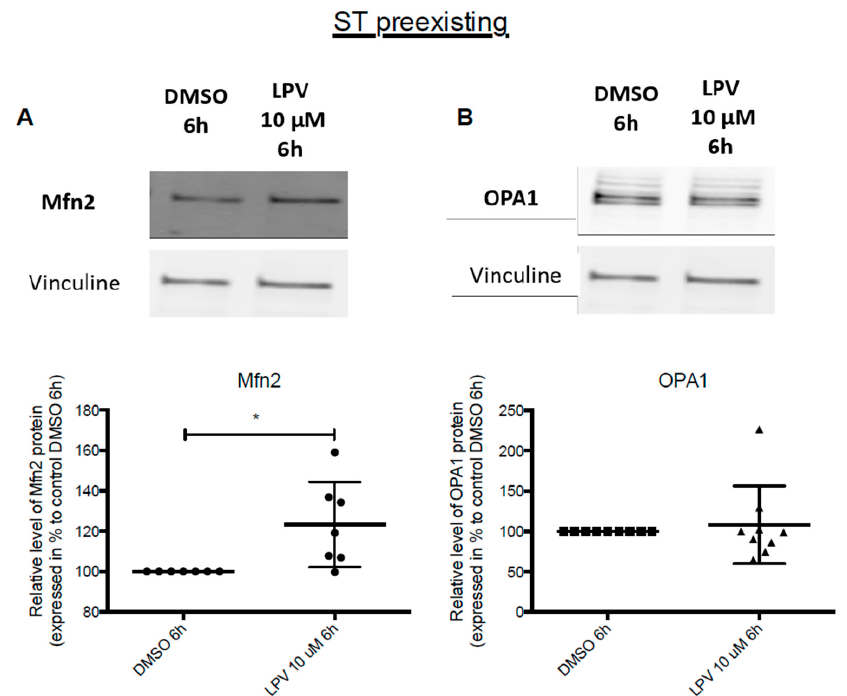
Figure 11. Impairment in mitochondrial dynamics in ST cells under LPV exposition. Cytotrophoblast cells isolated from human term placentas were cultured for 72 h before incubation with LPV 10 µ M or DMSO for 6 h. Mfn2 ( A ) and OPA1 ( B ) protein expression was evaluated by immunoblotting with anti-Mfn2 and anti-OPA1 antibodies. Vinculin protein expression determined with anti-vinculin antibody was used as loading control. Results are expressed as the mean +/ − SD of n = 7 independent experiments. * p < 0.05 vs. DMSO, two-tailed paired no parametric student t